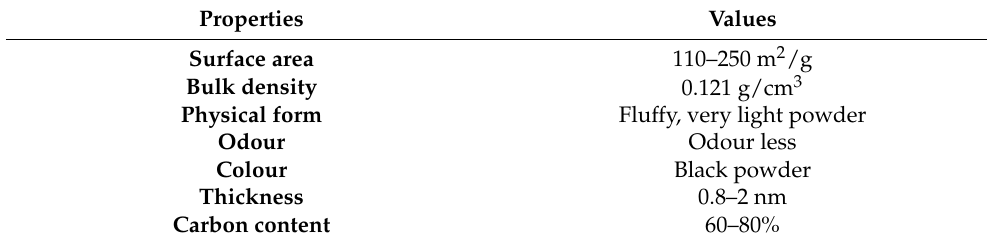
Table 2. Properties of graphene oxide.